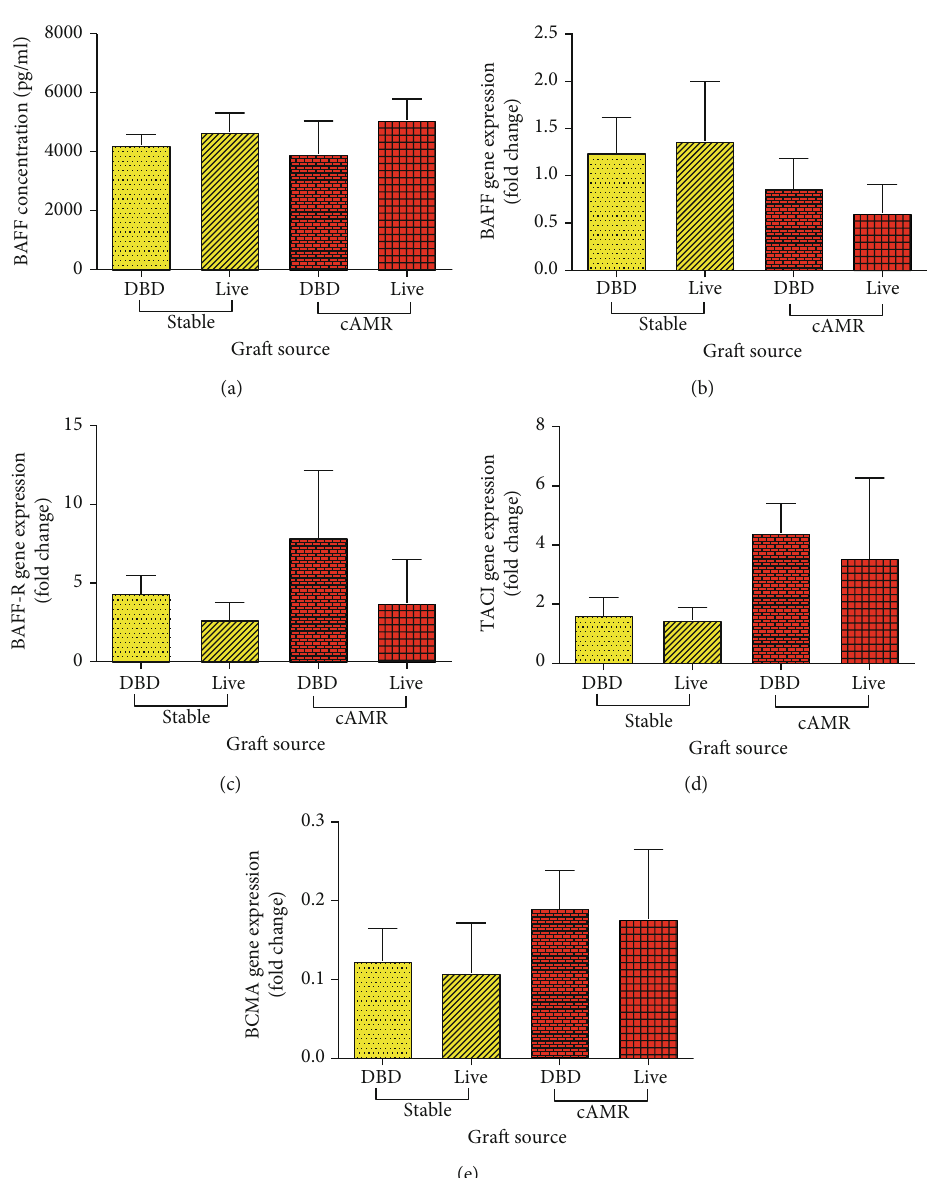
Figure 10: Comparing BAFF serum level (a), mRNA expression of BAFF (b), BAFF-R (c), TACI (d), and BCMA (e) between stable transplanted patients which received their graft from living or deceased donors and also cAMR patients which received their graft from living or deceased ones. Error bars represent